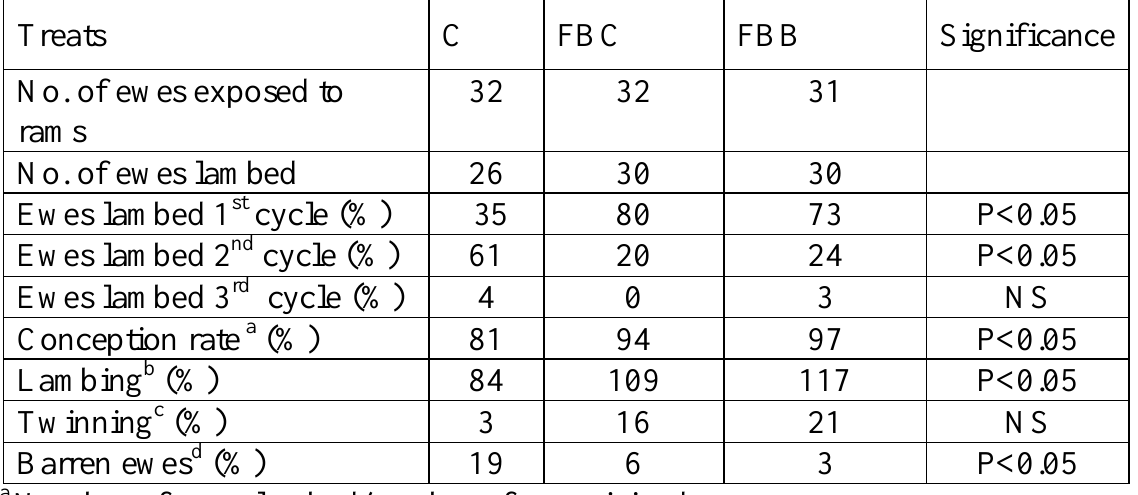
Table 4: Effect of feed block supplementation on reproductive performance of Awassi ewes grazing cereal stubble.